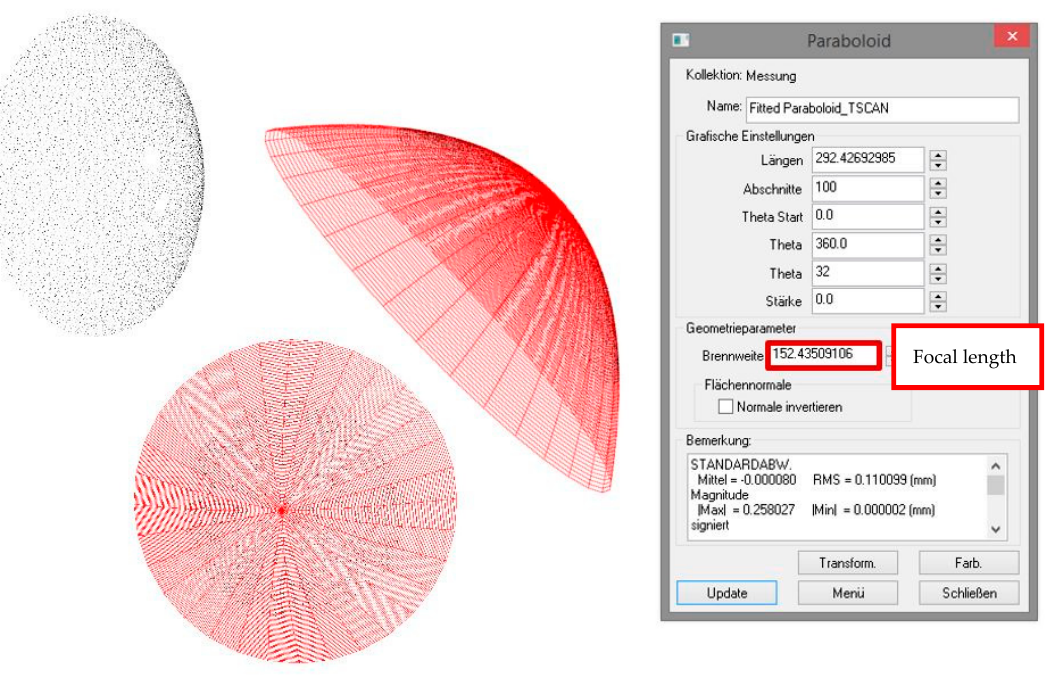
Figure 15. Focal length of paraboloid in mm derived from T-Scan 5 measurements and calculated with Spatial Analyzer .